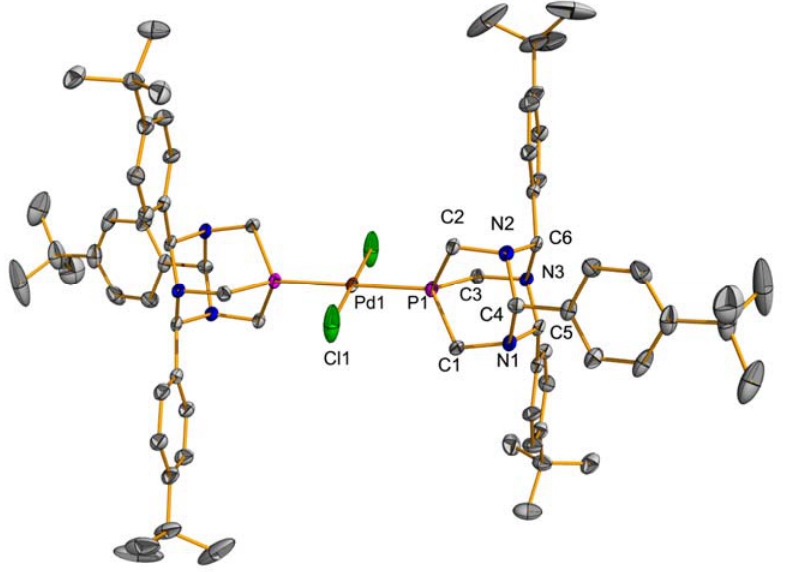
Figure 5. Thermal ellipsoid plot (50% probability) of 4 . Hydrogen atoms have been omitted for clarity. Selected bond lengths (Å) and angles (deg.): Pd1-Cl1 = 2.2911(17), Pd1-P1 = 2.2959(13), P-Pd-P1 = 180.0, Cl-Pd1-Cl1 = 180.0, Cl1-Pd1-P1 =